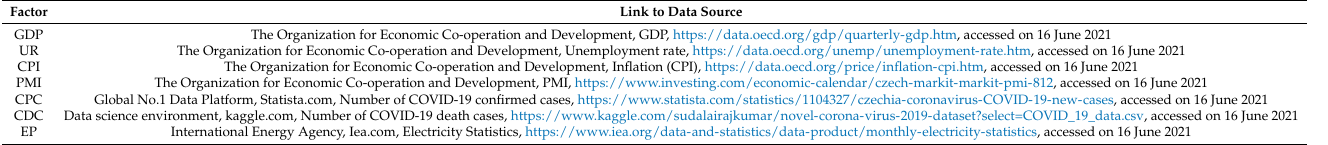
Figure 5. The proposed FLANN model. Table 3. Data sources for the economical factors used in simulation